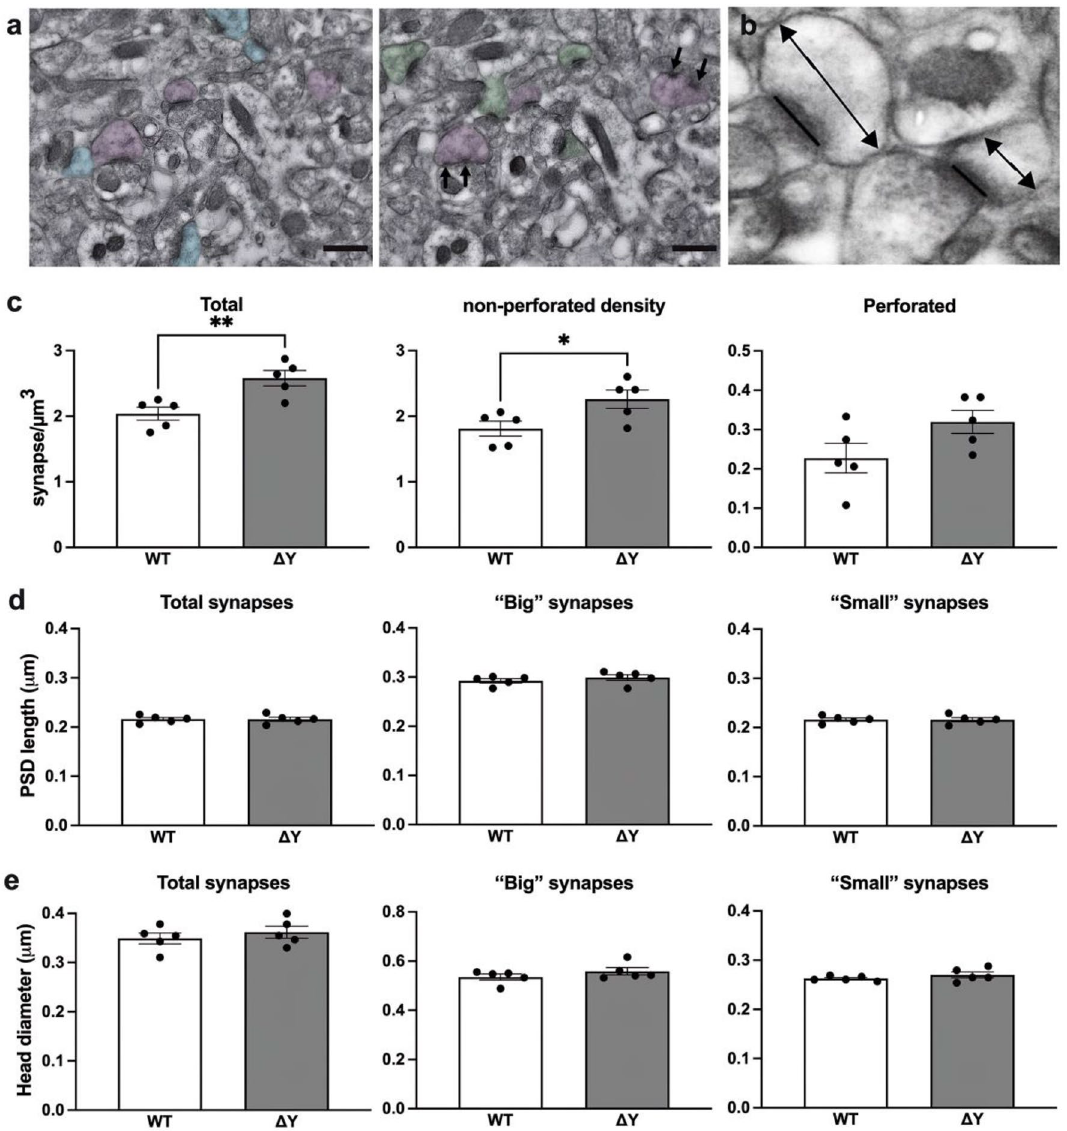
Figure 4. ΔY MHC-I mutation result in an increase in synapse density but does not affect PSD length or spine HD. ( a ) Electron micrographs depicting synapses counted using the disector method. Only asymmetric axospinous synapses that were present in the reference panel (green or blue), but not in the look-up panel were counted. Synapses present in both panels (purple) are not included. Non-perforated synapses are distinguished from perforated synapses by the presence of a discontinuity within the PSD (arrows). Scale bars = 500 nm. ( b ) EM micrograph illustrating how PSD length (straight line) and HD (line with arrows) was measured. ( c ) ΔY mice exhibited an increase in total synapse and non-perforated synapse density compared to WT. No differences were observed in perforated synapse density. No differences were observed in ( d ) PSD length or ( e ) HD of total, “small” and “big” synapses in ΔY mice compared to WT. * P < 0.05. ** P < 0.01. Data represent means ±